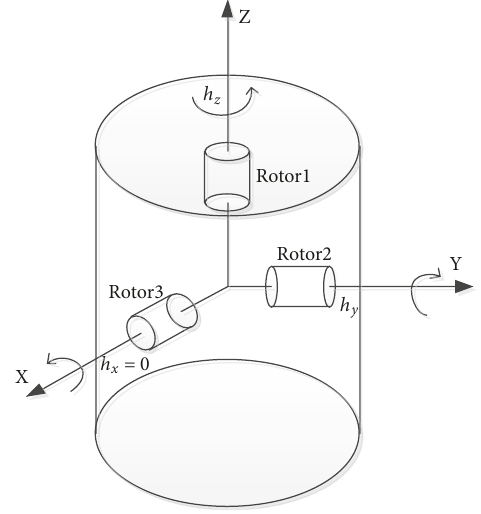
Figure 1: Gyrostat system